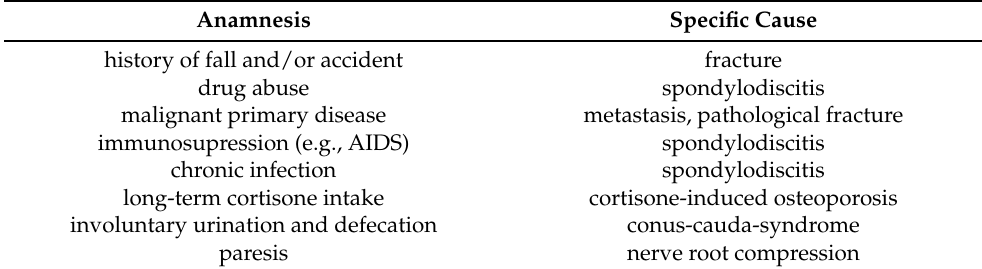
Table 1. “Red Flags”—specific causes of back pain symptoms.